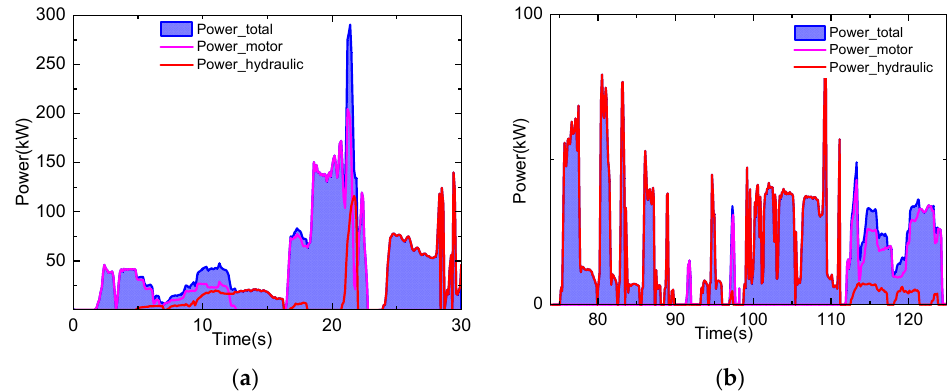
Figure 13. Power distribution of loading and dumping conditions: ( a ) loading condition distribution; ( b ) dumping condition distribution.